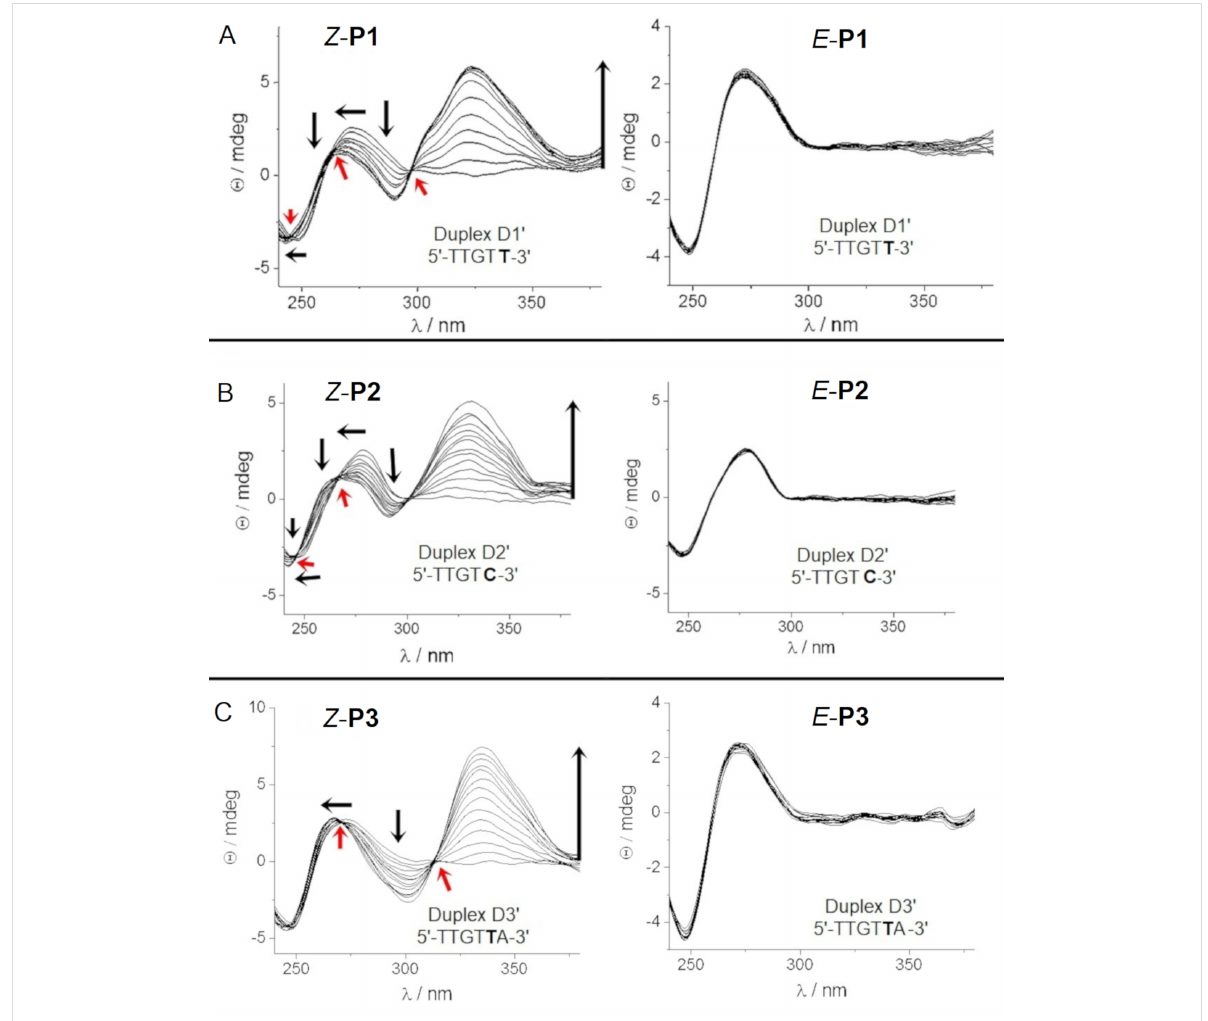
Figure 4: Titration of DNA containing single mutations (in bold) with P1 – P3 in the photostationary Z- state and the thermal E- state. See Table 1 for complete sequences.